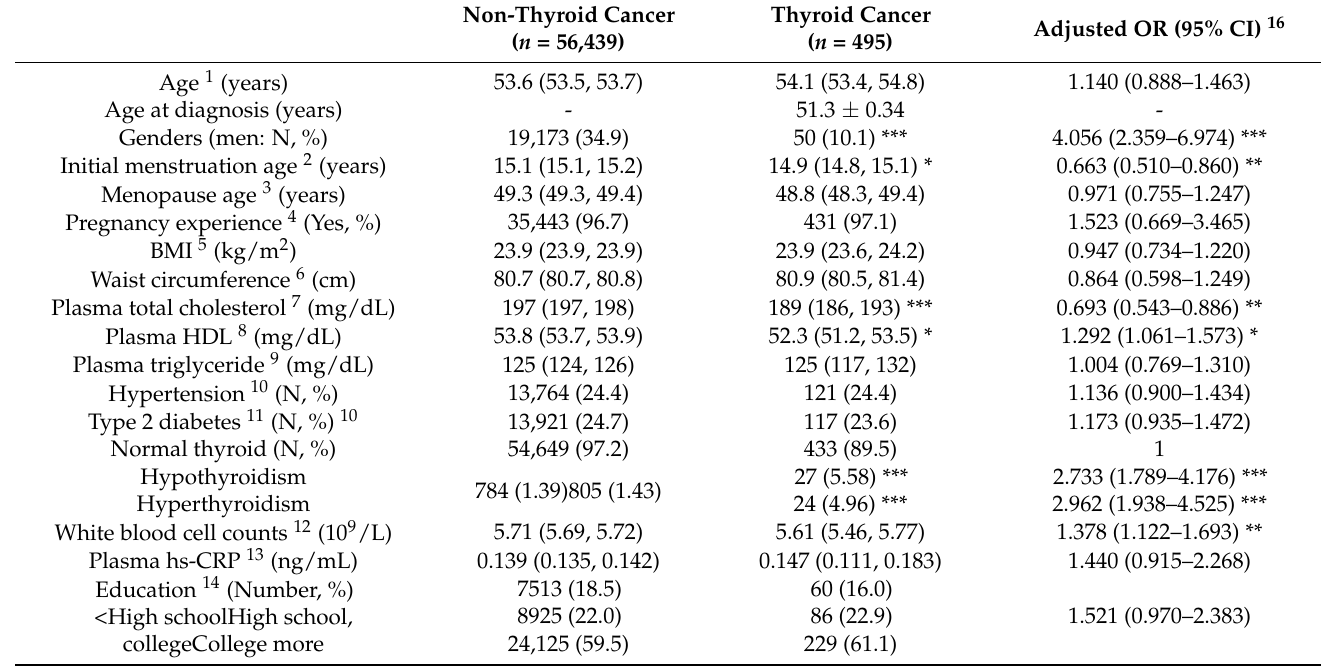
Table 1. Socioeconomic and metabolic characteristics of the participants according to thyroid